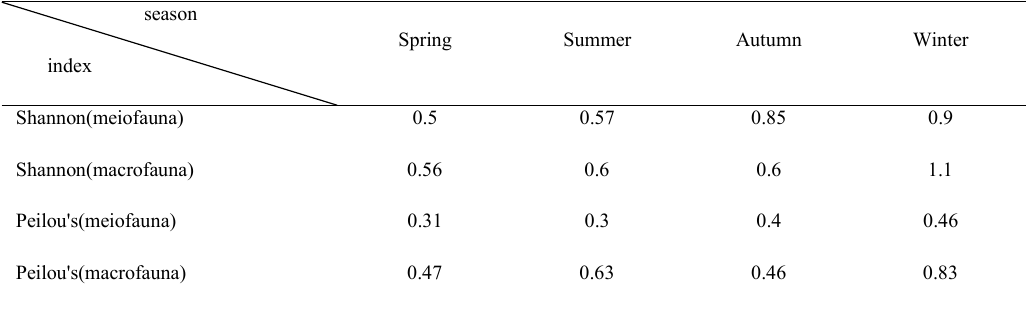
Table 5: Shnanon and Peiole index for meiofauna and macrofauna in different seaspns in the southern Caspian Sea from Behshahr to season